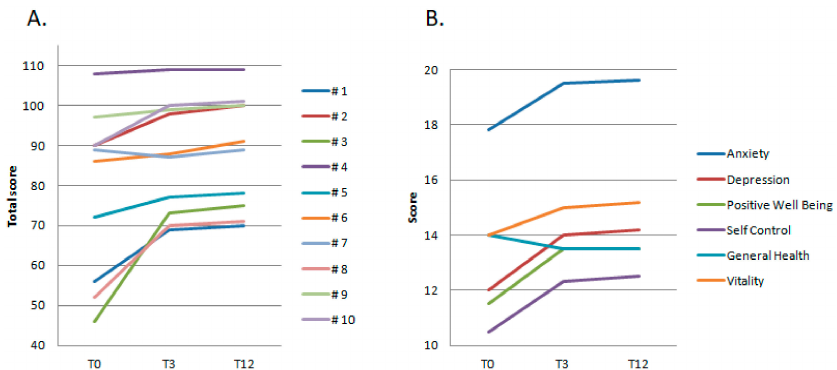
Figure 1. Psychological General Well-Being Index (PGWBI). ( A ) Total score index for each patient (#1–10) at T0 and after 3 and 12 months of LNAAs supplementation (T3; T12); ( B ) Mean values of the PGWBI subscales at T0, T3, and T12.